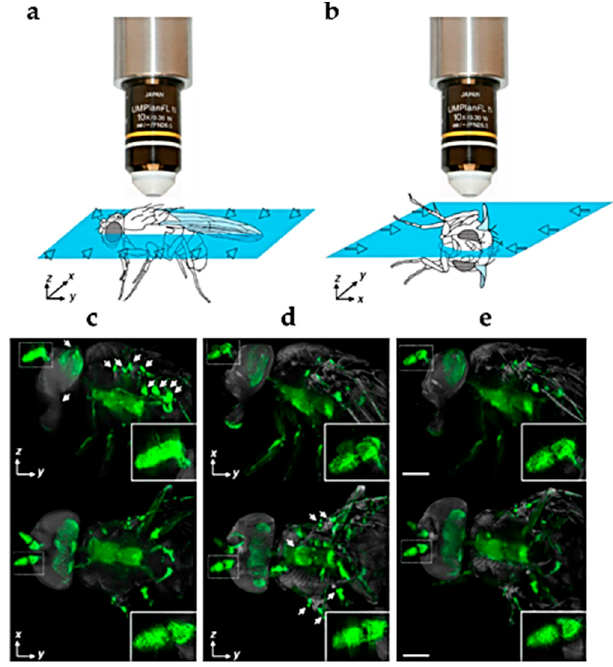
Figure 2. Representation of the orthogonal directions of light-sheet illumination to collect fluorescence signals through the Drosophila adult body ( a , b ), resulting in lateral (( c – e ) upper panel) and dorsal (( c – e ) lower panel) views. The multi-view reconstruction of combined stacks from ( c ) and ( d ) are shown in ( e ). Insets show the antenna at higher magnification. The topological localization of the GFP signal visible in green is facilitated by AF, representing in grey the overall body structures. Modified from [30]. Bars = 200 μ m.